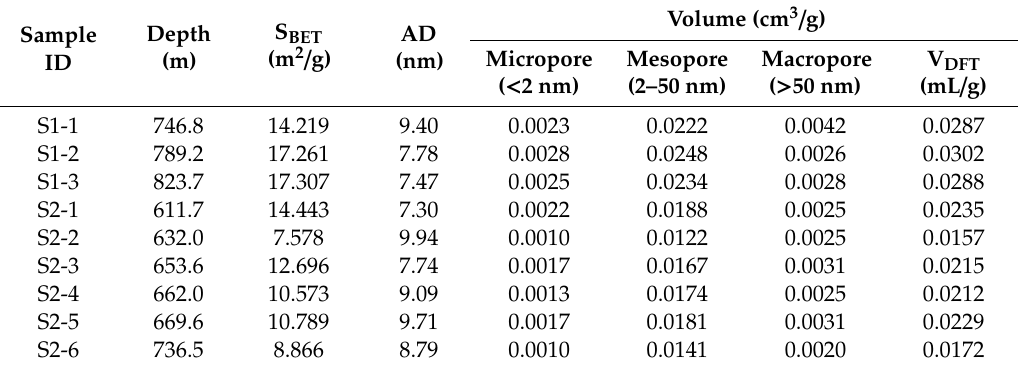
Table 2. Pore structure parameters of the shale samples from N 2 adsorption